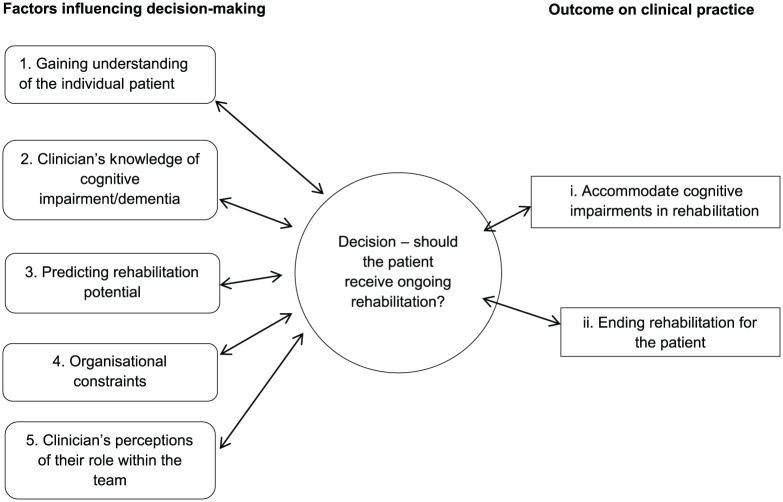
Thematic framework.